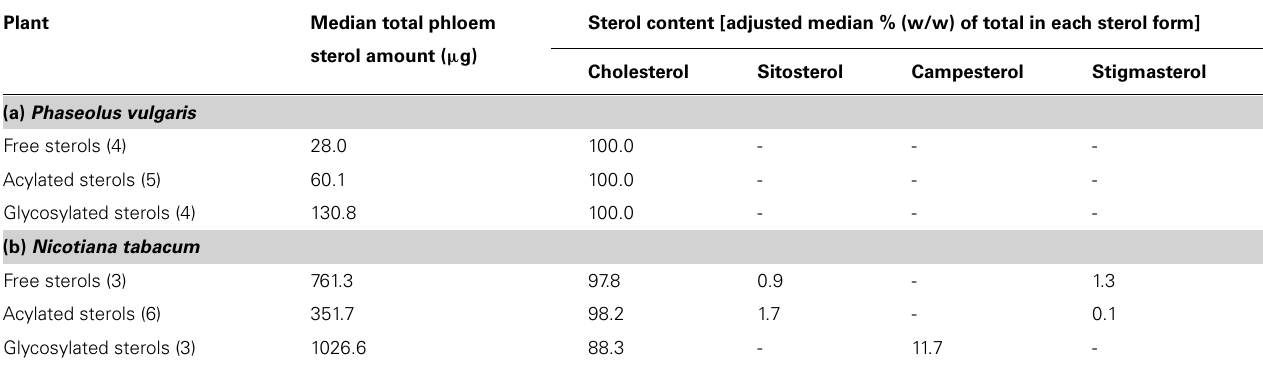
Glycosylated sterols